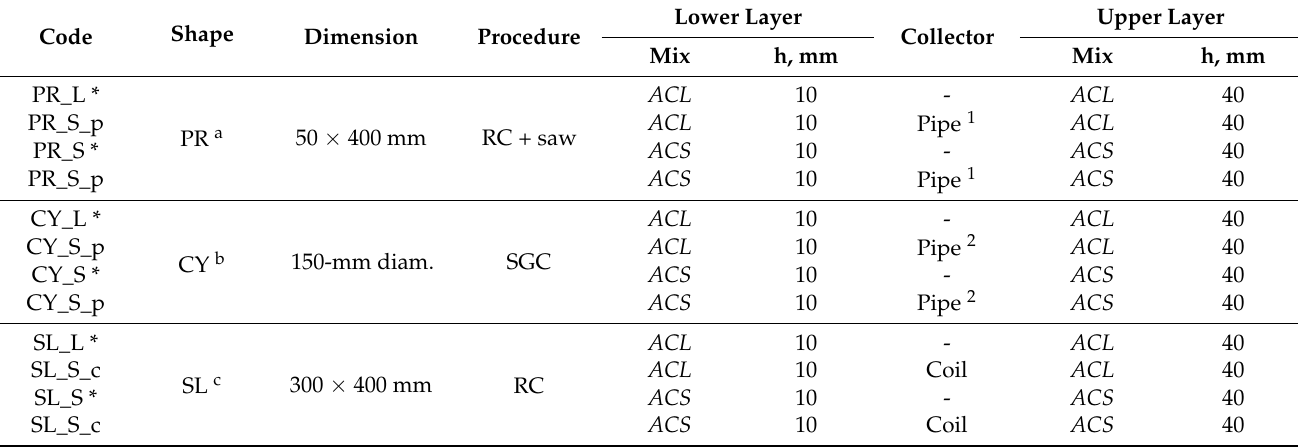
Table 3. Details about the produced